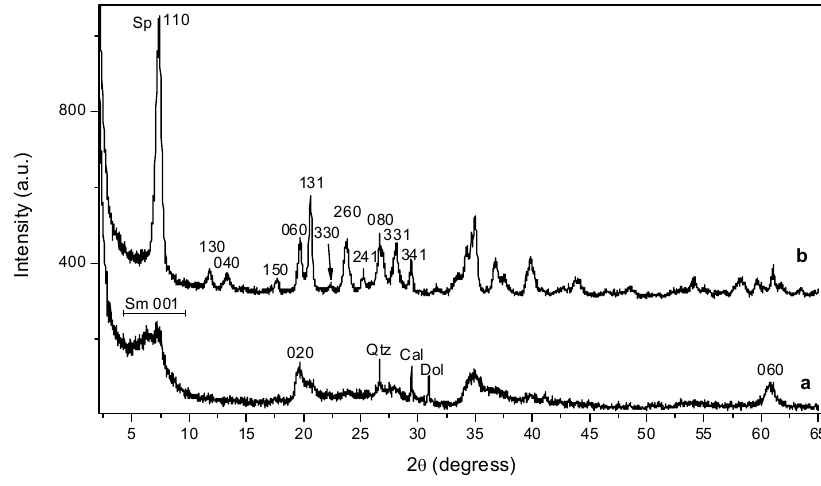
Figure 1. XRD patterns of starting Sm ( a ) and Sp ( b ).